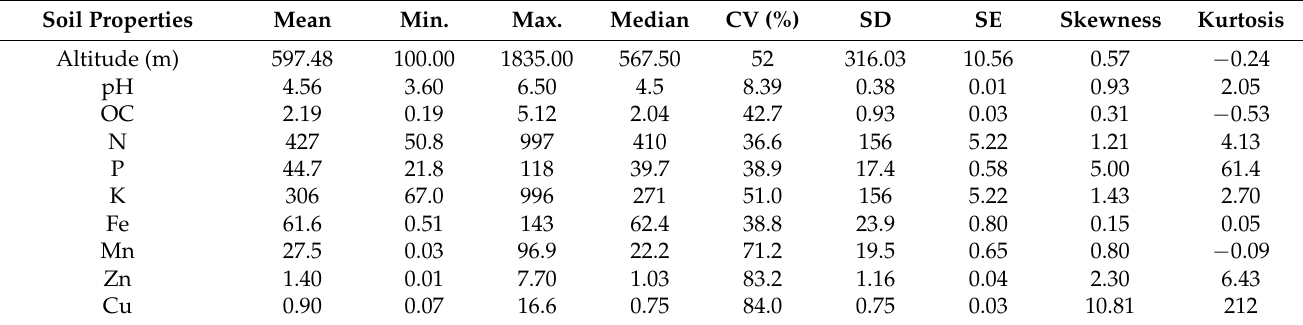
Table 2. Descriptive statistics of soil properties in India’s north-eastern Himalayan area.